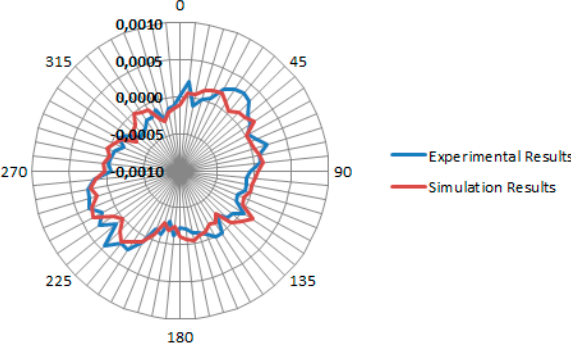
Figure 7. Comparison between results of experimental probe head errors identification and simulation using developed model for A = − 100 and B = 30.